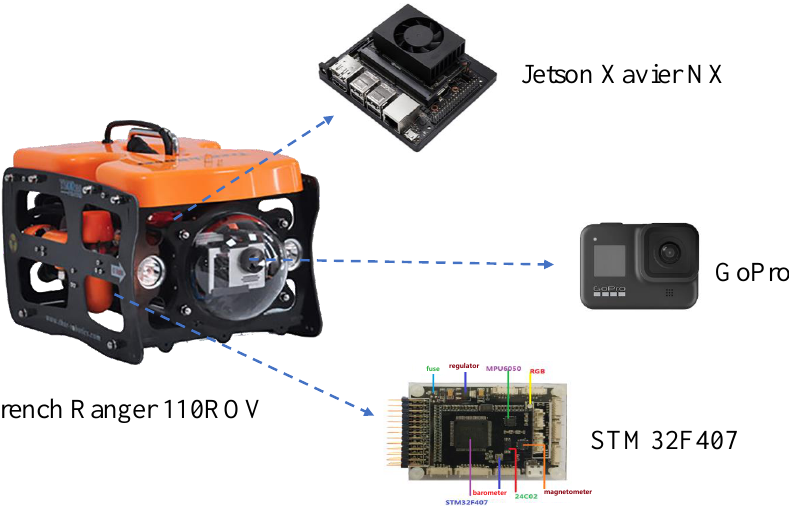
Figure 14. Overall UAR structure. It consists of the ROV, Jetson Xavier NX (core processing unit), a GoPro7 (underwater camera), an STM32 control board, and other